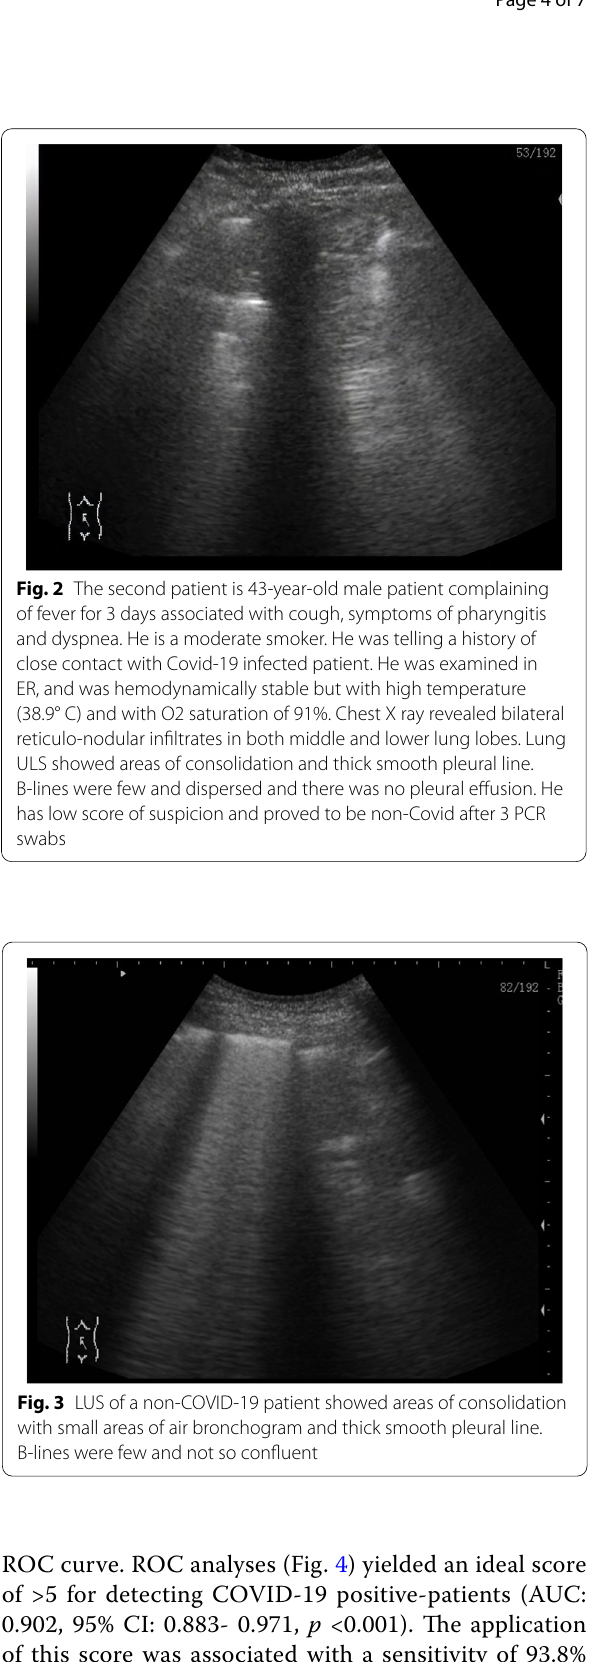
ROC curve. ROC analyses (Fig. 4) yielded an ideal score of >5 for detecting COVID-19 positive-patients (AUC: 0.902, 95% CI: 0.883- 0.971, p <0.001). The application of this score was associated with a sensitivity of 93.8% and specificity of 58%.